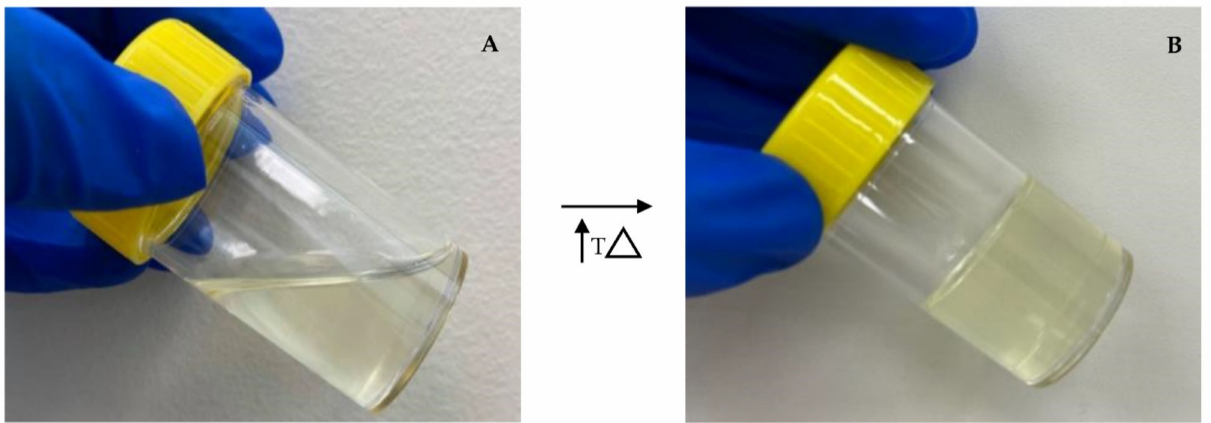
Figure 5. Representative photograph of F4. ( A ) Sol form at storage temperature 2–8 ◦ C. ( B ) Gel form at nasal temperature 32 − 34 ◦